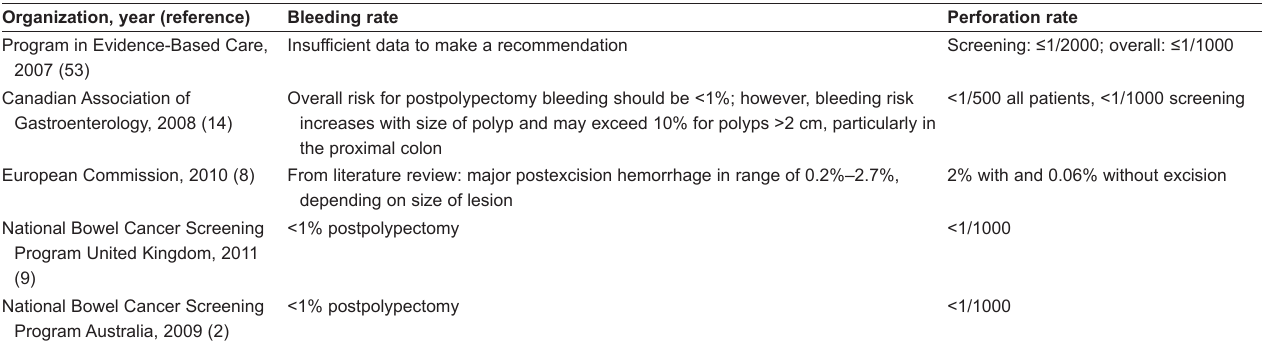
TAble 9 Safety cut-off found in the review of guidance